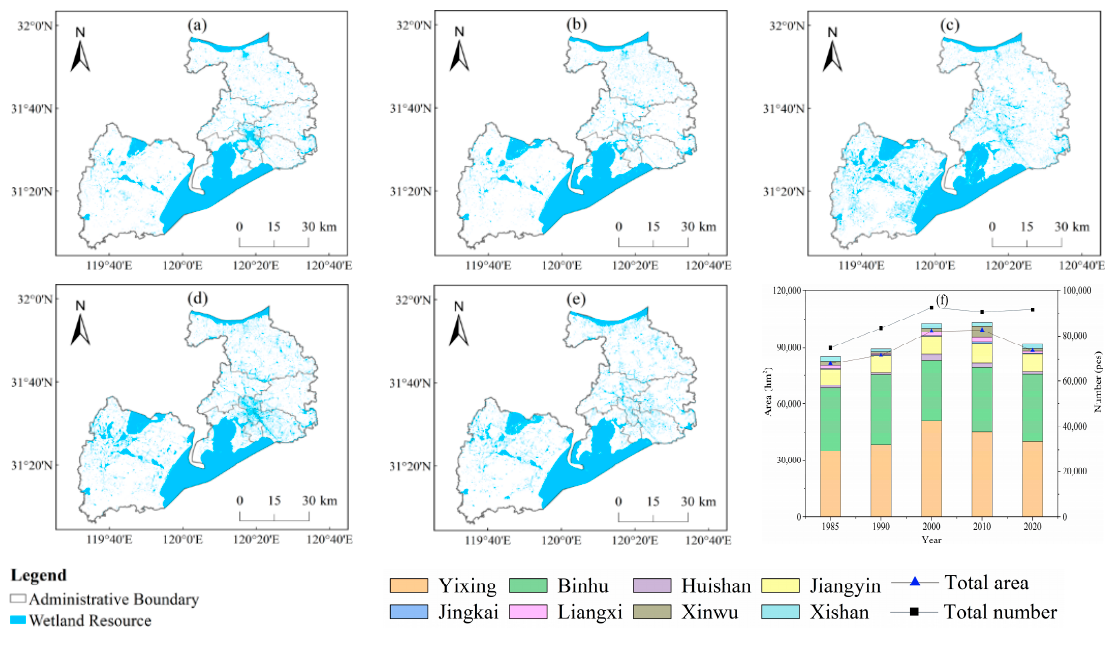
Figure 4. Changes in natural wetlands in Wuxi area from 1985 to 2020: 1985 ( a ), 1990 ( b ), 2000 ( c ), 2010 ( d ), 2020 ( e ), and district area overlay map ( f ). In terms of area, the natural small and micro wetlands in Wuxi area were divided